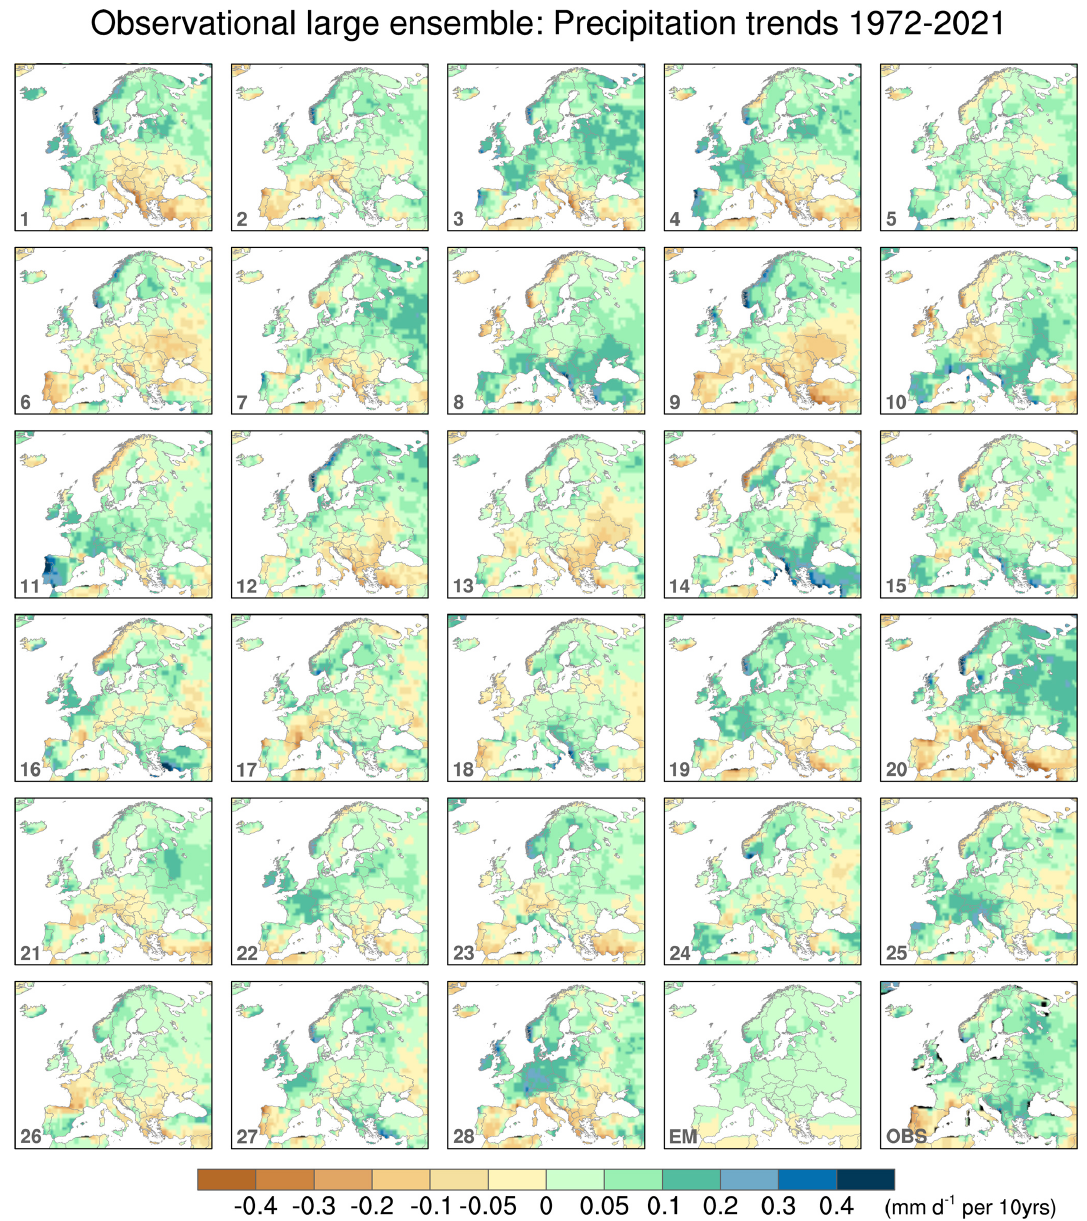
Figure 4. As in Fig. 2 but for the observational large ensemble of McKinnon and Deser (2018), with the ensemble mean from the 100- member CESM2 large ensemble. See text for